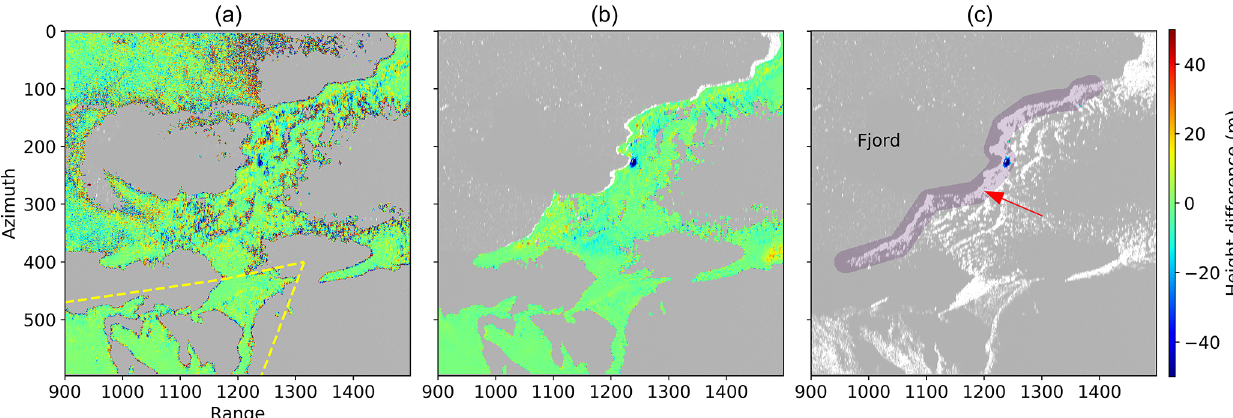
Figure 4. Example of a calving event extraction on 20 August 16:40UTC in radar geometry. Panel (a) shows the elevation difference between two unstacked DEMs, while in (b) the difference is calculated between two stacked DEMs. (c) The image shows the final extracted calving event (blue). The red arrow indicates the general flow direction of the glacier, while the purple shaded area shows the front mask. The yellow marked area shows the stable terrain used for the uncertainty analysis.